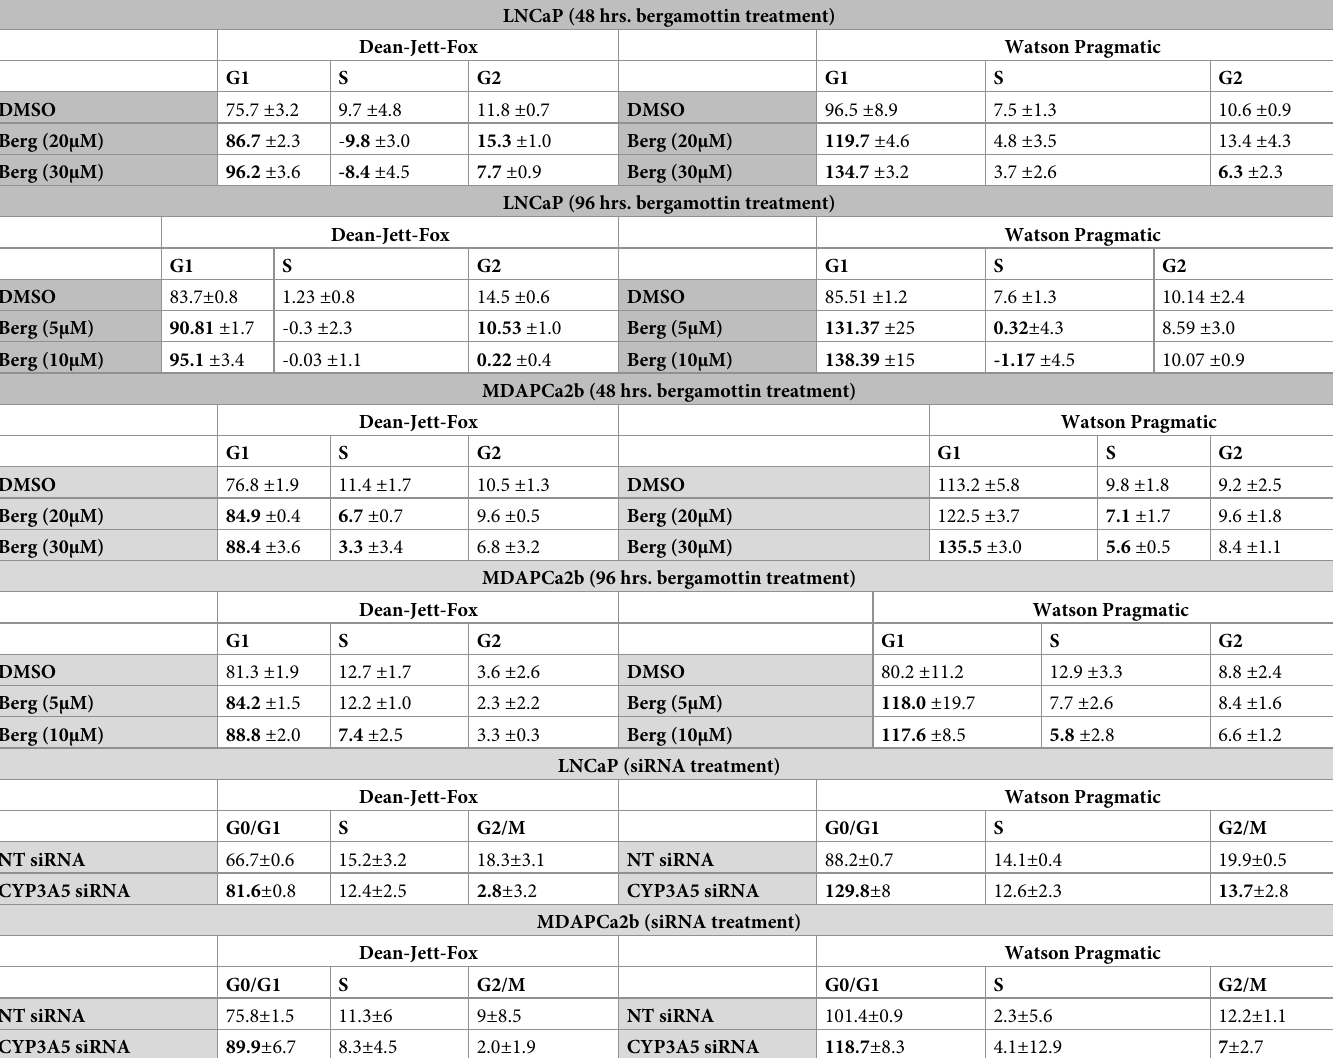
Table 1. Cell cycle analysis showing effect of bergamottin and CYP3A5 siRNA treatment in LNCaP and MDAPCa2b cells.